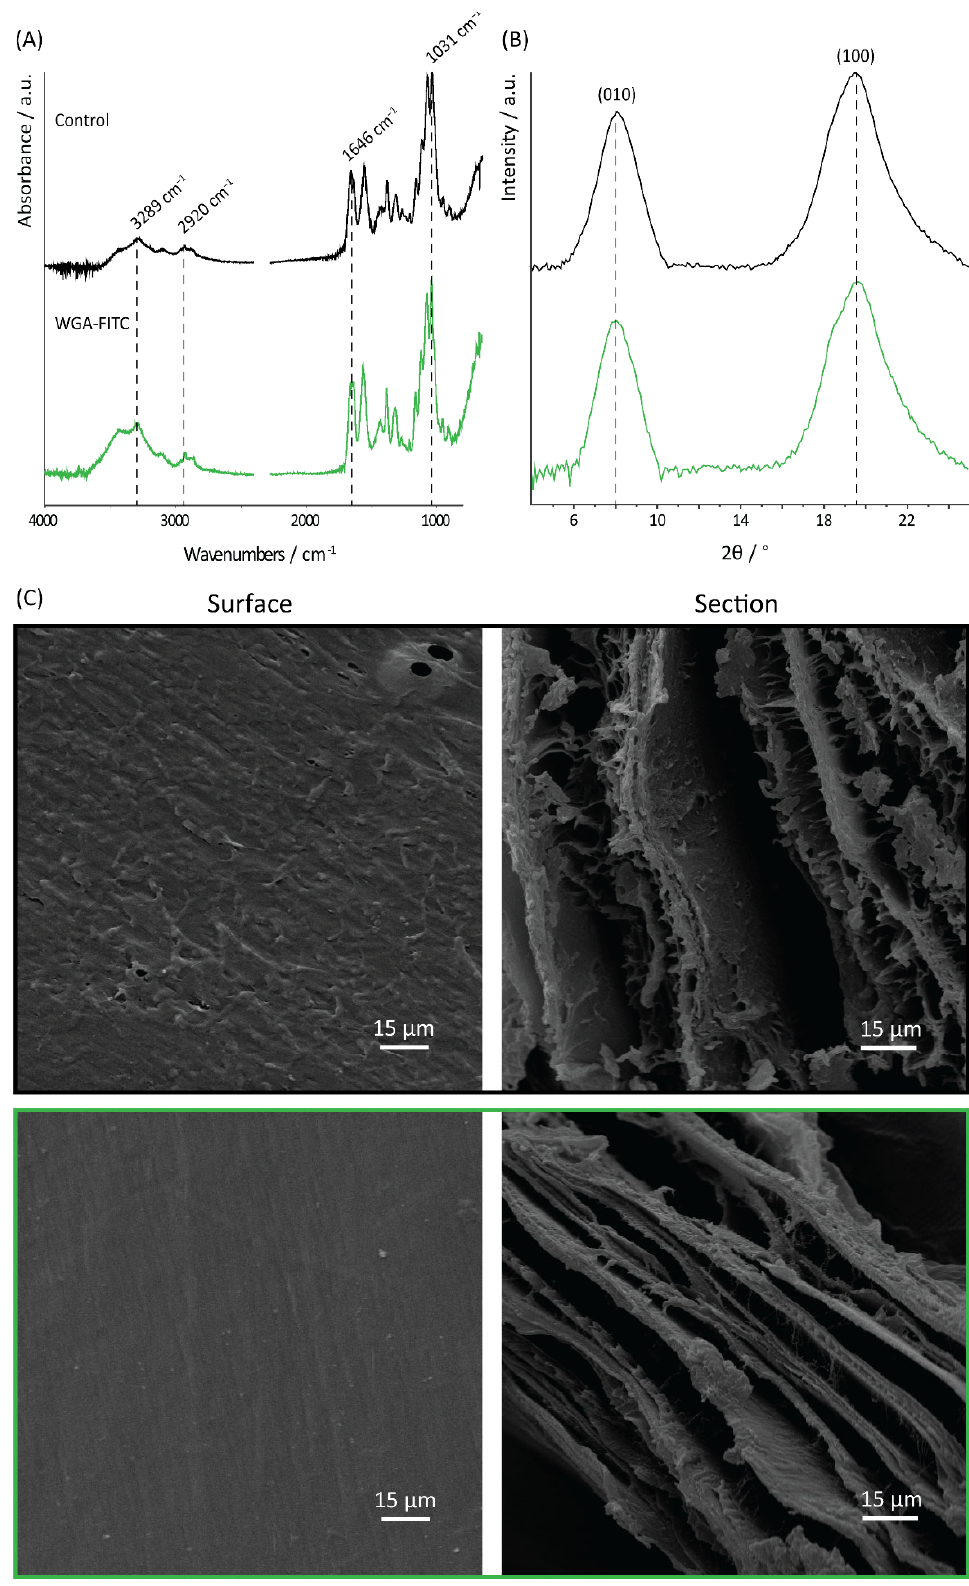
Figure 3. Structural and morphological analyses of the matrix. ( A ) FTIR, ( B ) XRD, and ( C ) SEM analyses of the blank chitin control (black line) and the WGA-FITC-treated chitin samples (green line). Surface image magnification is 800X and the cross ‐ section image magnification is 1000X.